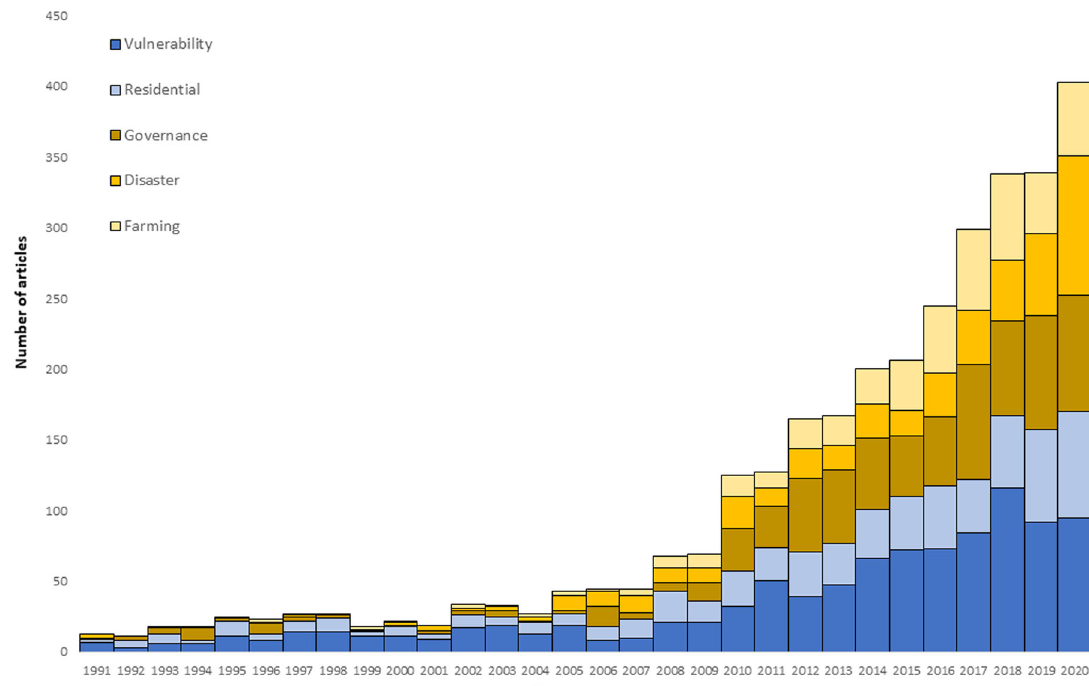
Fig. 3 Number of articles by publication year from 1991 – 2020. Trends for the fi ve topic clusters in two themes-Impact (blue) and Adaptation (yellow) (n =